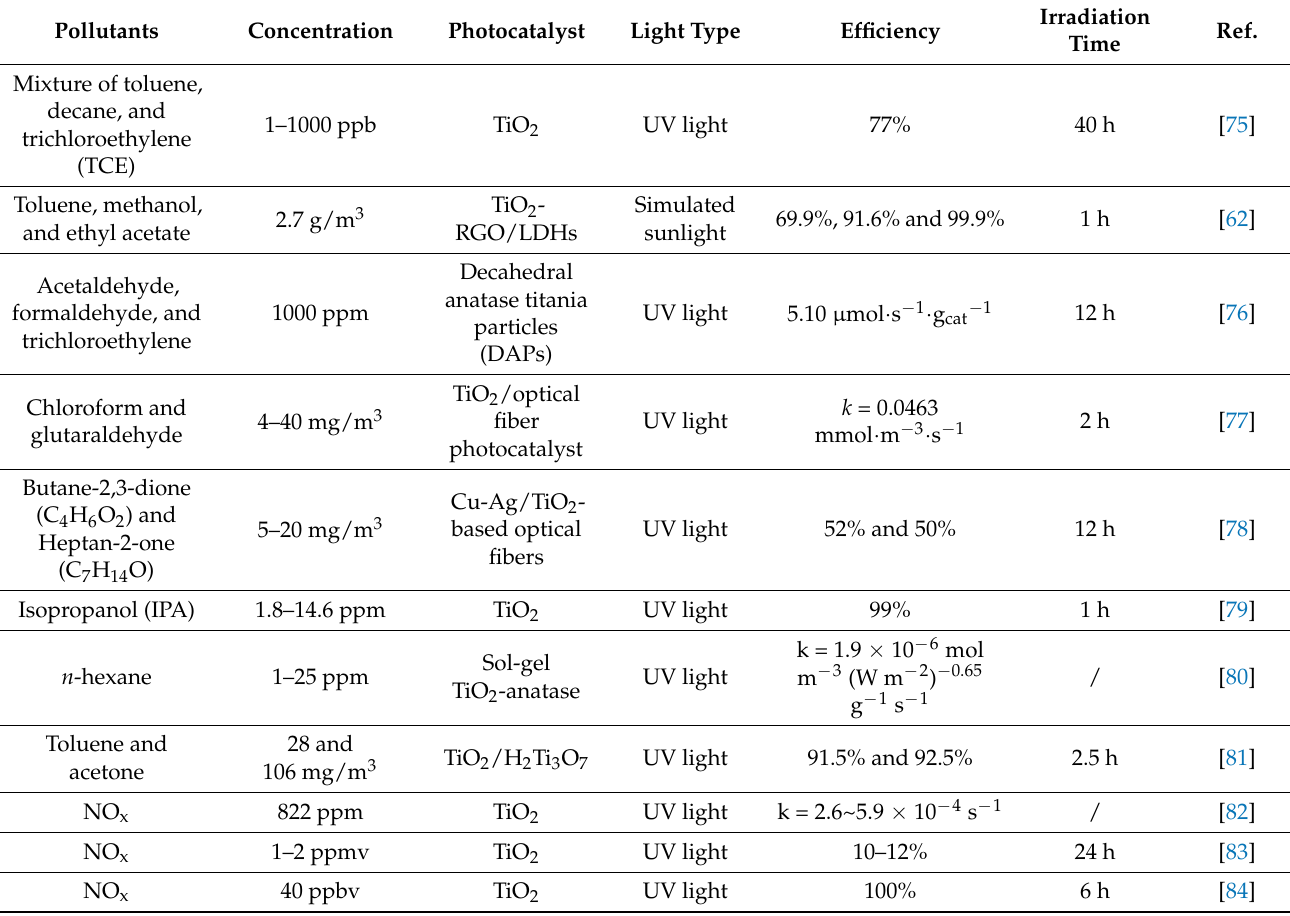
Table 2. Photocatalytic treatment of vehicle exhaust